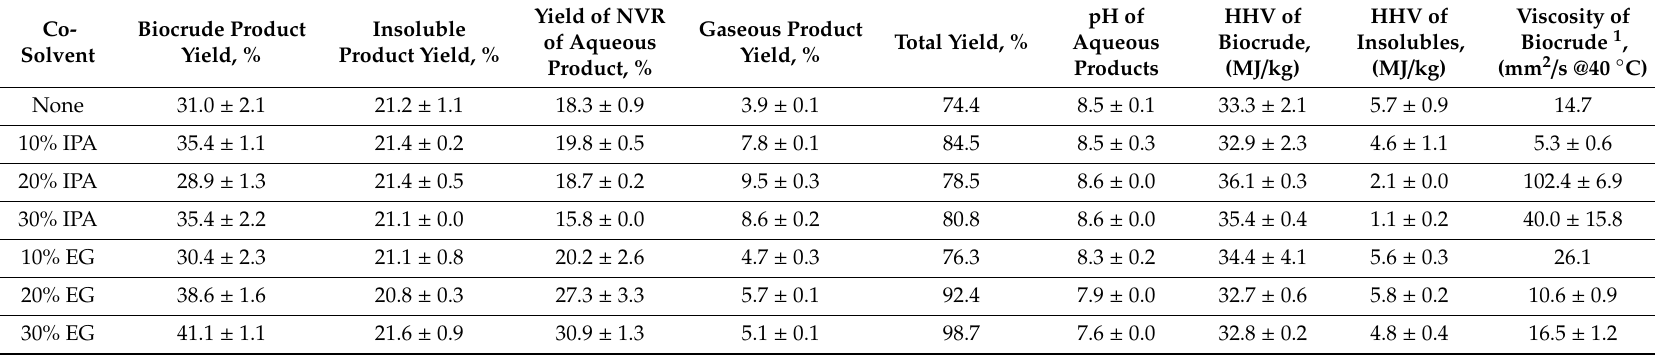
Table notes: NVR—Non-volatile residue; HHV—Higher heating value; IPA—Isopropyl alcohol; EG—Ethylene glycol. 1 Viscosity was measured by a Zeitfuchs cross-arm flow viscometer at 40 ◦